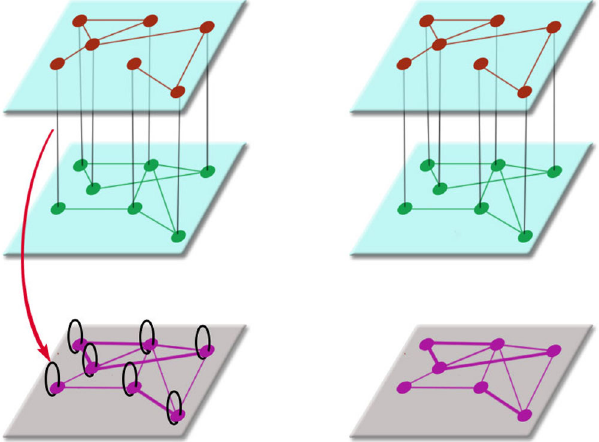
FIG. 3. Schematics of (left) projected and (right) overlay monoplex networks obtained from a multilayer network. Both types of single-layer networks are weighted, but their edges have different weights. One obtains an overlay network using the contraction operator and thus neglects the influence of interlayer